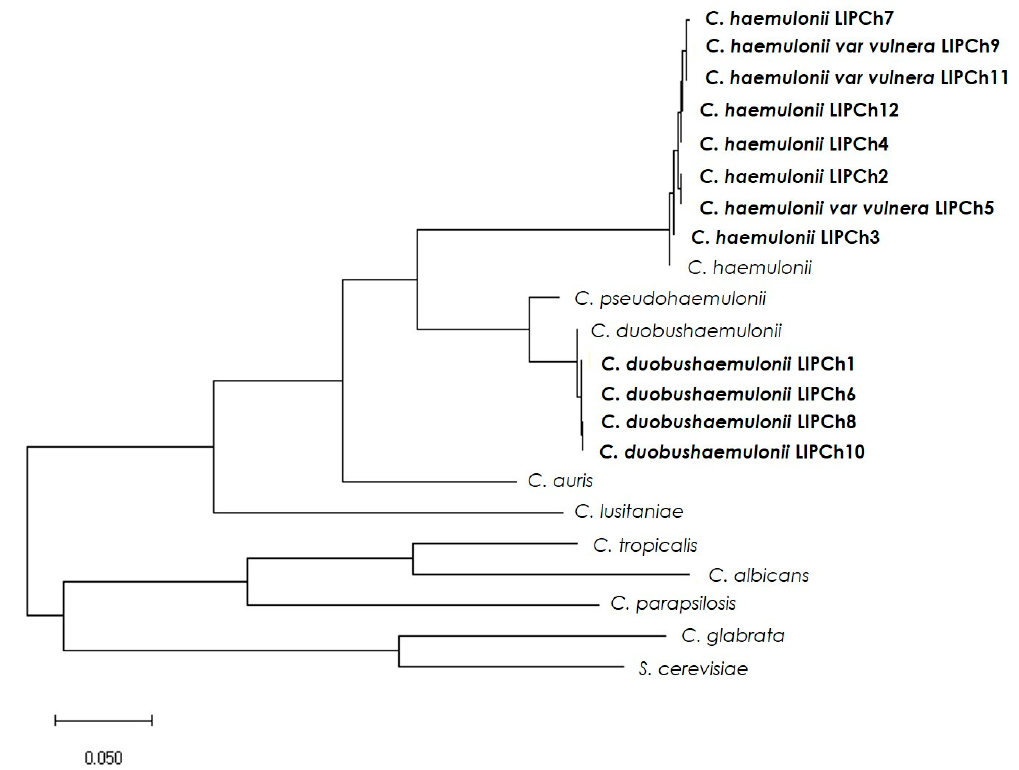
Figure 4. Phylogenetic tree of the ERG11 gene from different Candida spp. The alignment was generated by the CLUSTAL W program and the phylogram was constructed using the “Maximum likelihood” method using the MEGAX software [34]. ERG11 and its orthologous amino acid sequences (followed by NCBI access numbers in parentheses): Saccharomyces cerevisiae S288C lanosterol 14 α -demethylase (NM_001179137.1), Candida glabrata ATCC 90030 lanosterol 14 α